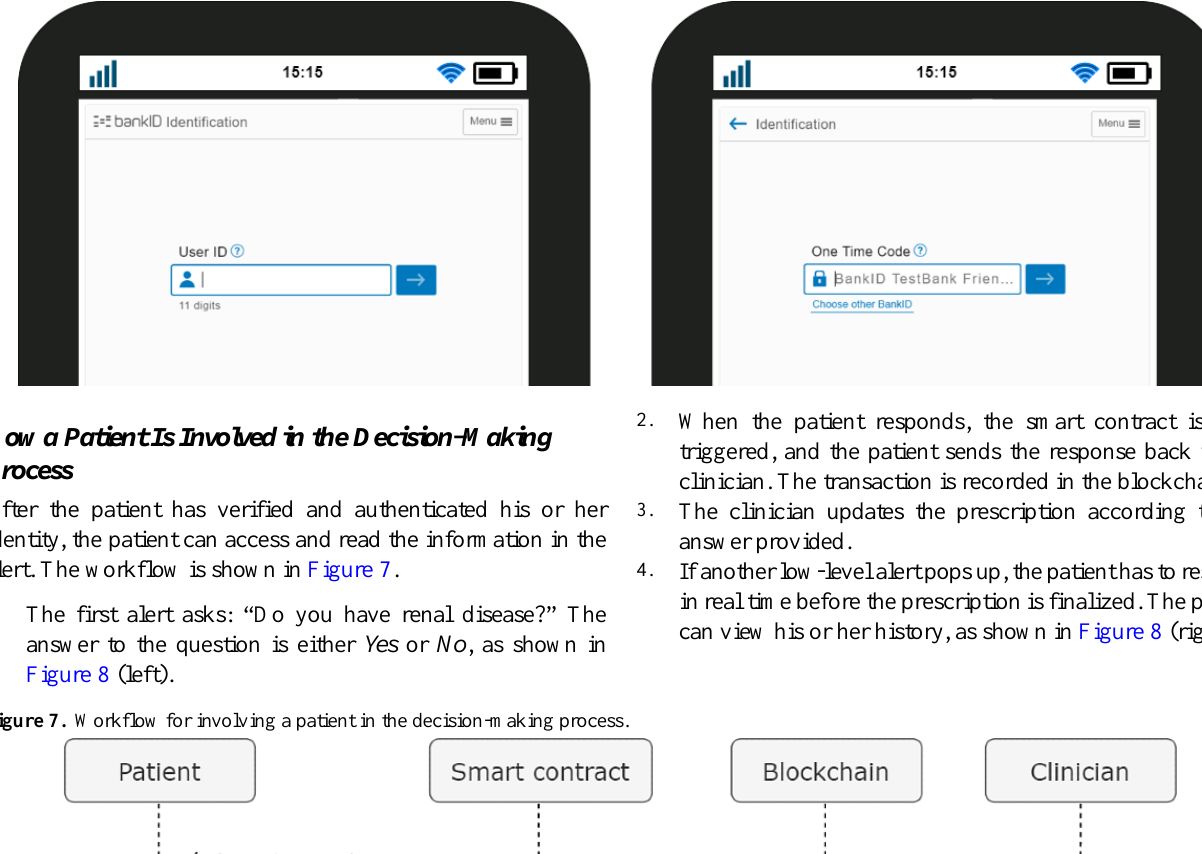
Figure 6. Personal credentials to verify identity (left) and request of one-time code to authenticate (right).